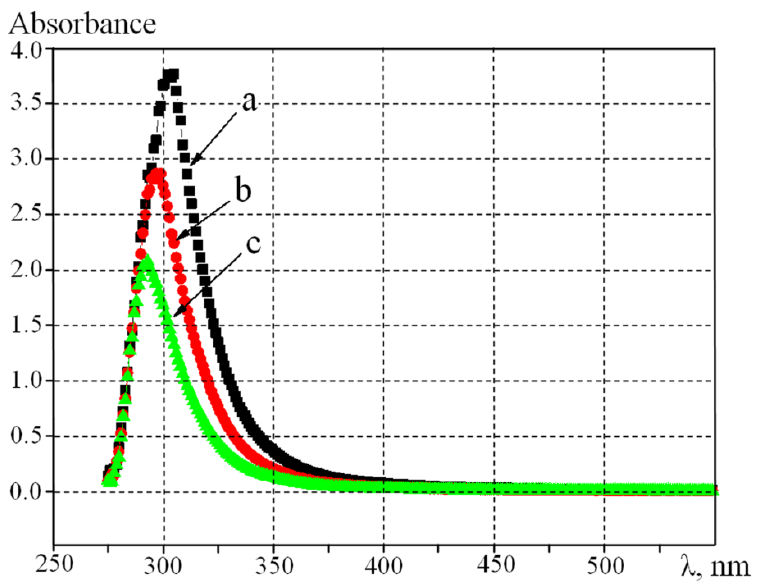
Figure 2. UV-visible spectra of polyimide solutions: ( a ) 1%, ( b ) 0.5%, and ( c ) 0.25% in dimethylformamide (DMF).